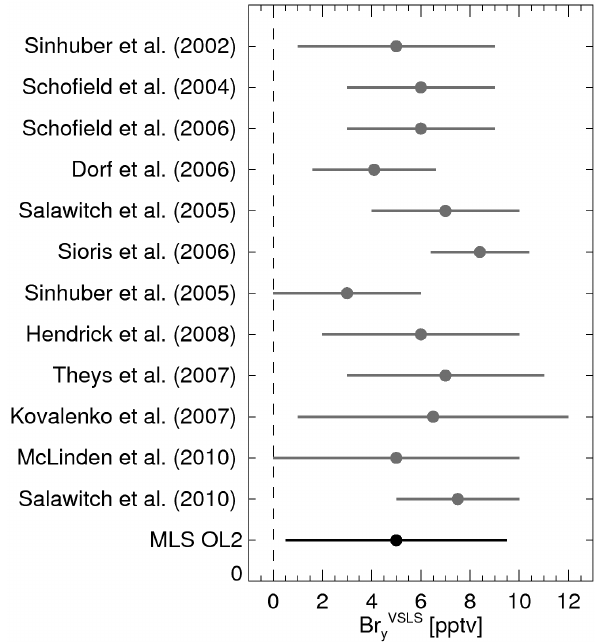
VSLS y from VSLS (Br y ) contribution to stratospheric bromine derived from BrO measurements as discussed in chapter 1 of WMO (2010) (gray lines) plus the Br VSLS y estimate made in this study (black